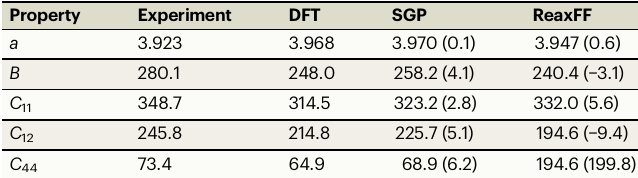
Table 2 | Properties of bulk Pt, compared with experimental measurements and calculations using DFT, the SGP model, and the ReaxFF model 45 : the lattice constant a ( Å ); the bulk modulus B (GPa); and the elastic constants C 11 , C 12 , and C